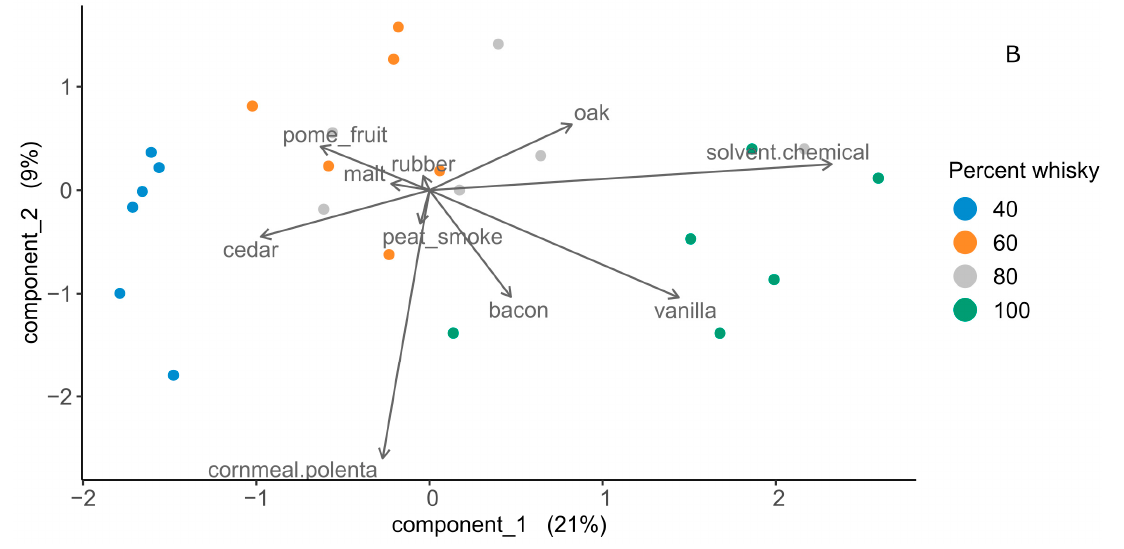
Figure 5. Partial least squares discriminant analysis (PLS-DA) biplot of sensory attributes and whisky styles ( A ) and dilution factor ( B ). In general, smokey terms (“Rubber”, “Bacon”, and “Peat Smoke”) were associated with peated single malt Scotch whisky (SM), “Vanilla” and “Oak” were associated with Bourbons (BU), and “Pome fruit” was associated with unpeated, blended Scotch whisky (BS). Undiluted whisky more directly correlated with “Solvent/Chemical”, “Vanilla”, “Bacon”, and “Oak” aromas while heavier dilution favored “Pome fruit”, and “Cedar”